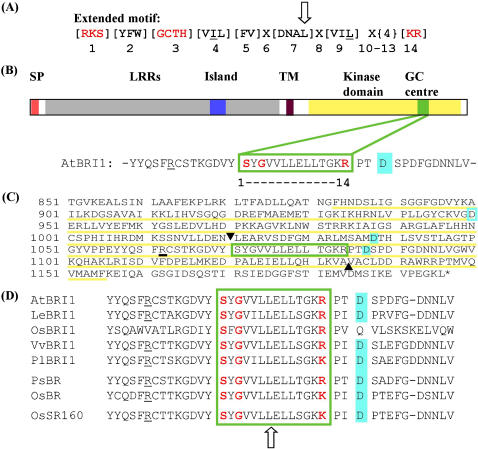
Structural features of the GC catalytic domain and the Arabidopsis thaliana brassinosteroid receptor AtBRI1.(A) The 14 amino acid long original search motif (modified after [12] with an inclusion of [L] in position 7). Red amino acids are functionally assigned residues of the catalytic centre. The residue in position 1 does the hydrogen bonding with the guanine, the amino acid in position 3 confers substrate specificity and the residues in positions 10 and 14 stabilise the transition (GTP/cGMP). (B) Representation of the domain organisation of AtBRI1 containing a signal peptide (SP), leucine rich repeats (LLRs) including an island, a transmembrane domain (TM), a GC centre embedded in the kinase domain. The position (16 or 17) outside the catalytic centre is implicated in Mg2+/Mn2+-binding (aquamarine). (C) Amino acid sequence of the intracellular C-terminal region of AtBRI1. The kinase domain is underlined (yellow), the GC domain is boxed in green, putative Mg2+/Mn2+-binding sites are highlighted (aquamarine), the proposed PPi binding is underlined in black, and the recombinant protein (AtBRI1-GC) tested for GC activity in vitro is delineated by solid triangles (σ). (D) Alignment of AtBRI1-like sequences. AtBRI1 (At4g39400), LeBRI1 (tomato|TC185049, Q9LJF3), OsBRI1 (Os06g0691800), VvBRI1 (grape |TC70352, Q9ZWC8), PlBRI1 (poplar|TC57820, Q9ZWC8), PsBR (BAC99050), OsBR (Os08g25380), OsSR160 (BAD34326.1, AP006156.2).